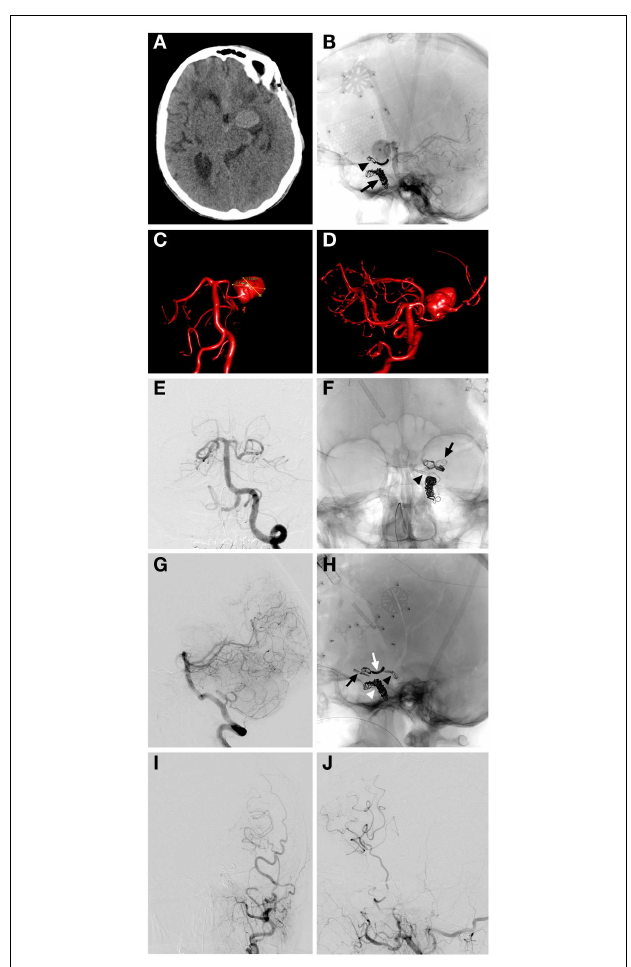
FIGURE 2 | Case 2 . (A) Non-contrast CT demonstrating a hyperattenuated left sylvian lesion with subarachnoid blood around the aneurysm and anterior interhemispheric fissure; (B) lateral unsubtracted skull radiograph showing the previously placed microsurgical clip (arrowhead) and coil mass from previous left ICA coil occlusion (arrow); (C,D) AP and oblique 3D angiographic reconstructions of vertebrobasilar system demonstrating the giant left supraclinoid ICA aneurysm being supplied by the left PComm; (E) AP subtracted angiographic view of left vertebral artery injection showing no filling of the giant aneurysm post clipping of left Pcomm; (F) AP skull x-ray demonstrating the two microsurgical clips used for feeding artery occlusions of a giant aneurysm with one clip over the Pcomm (arrowhead) and one over the supraclinoid ICA segment (arrow), previous coil mass from LICA occlusion and curved clip from previous clipping also seen; (G) lateral projection left vertebral artery angiographic injection showing no residual filling of giant aneurysm by the Pcomm; (H) lateral skull x-ray film demonstrating the clip from prior clipping (white arrow), coil mass from previous left ICA occlusion (white arrowhead), left Pcomm clip at the left Pcomm-P1 junction (black arrowhead), left supraclinoid ICA clip (black arrow); (I,J) AP and lateral left external carotid angiographic projections demonstrating filling of left superficial temporal artery with a patent bypass to left MCA and filling of left MCA territory post microsurgical occlusion of arterial feeders to aneurysm.